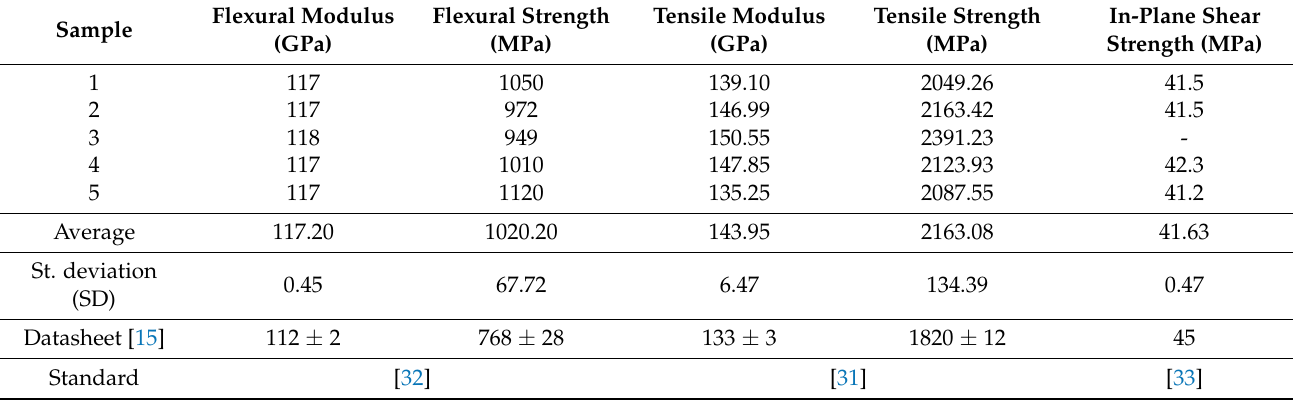
Table 2. Material characterisation results.